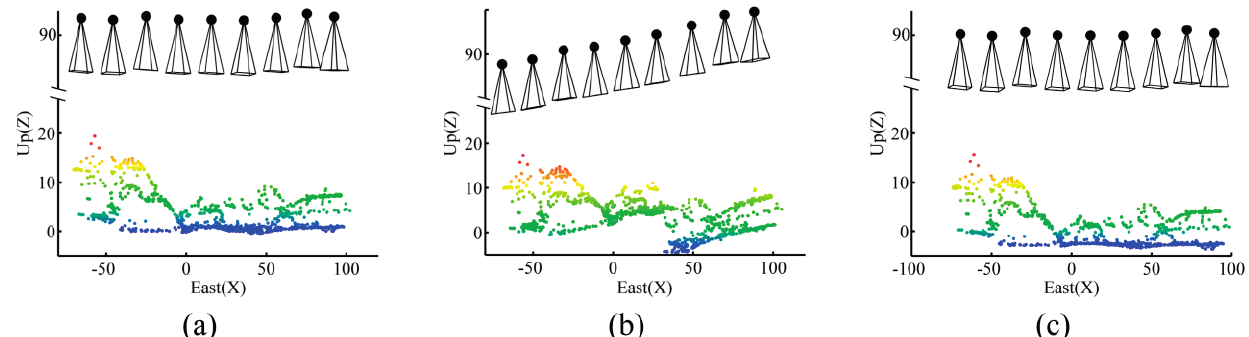
Figure 24. Effect of imaging configuration ( a ) Inner-constrained adjustment based on OverlapTest 1; ( b ) Inner-constrained adjustment based on OverlapTest 2; ( c ) Controlled adjustment based on OverlapTest 2 using four